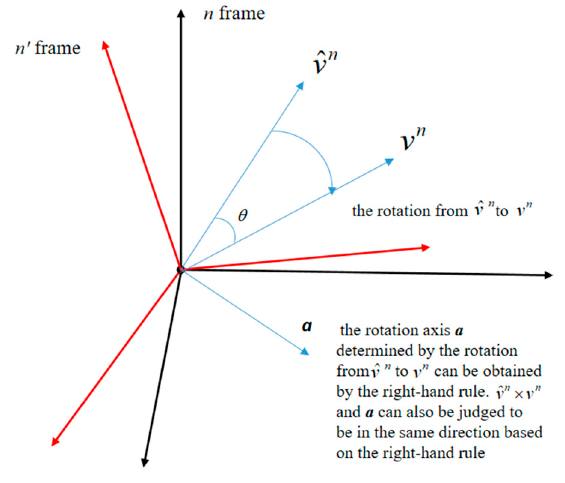
Figure 2. Schematic diagram of the rotation relation.